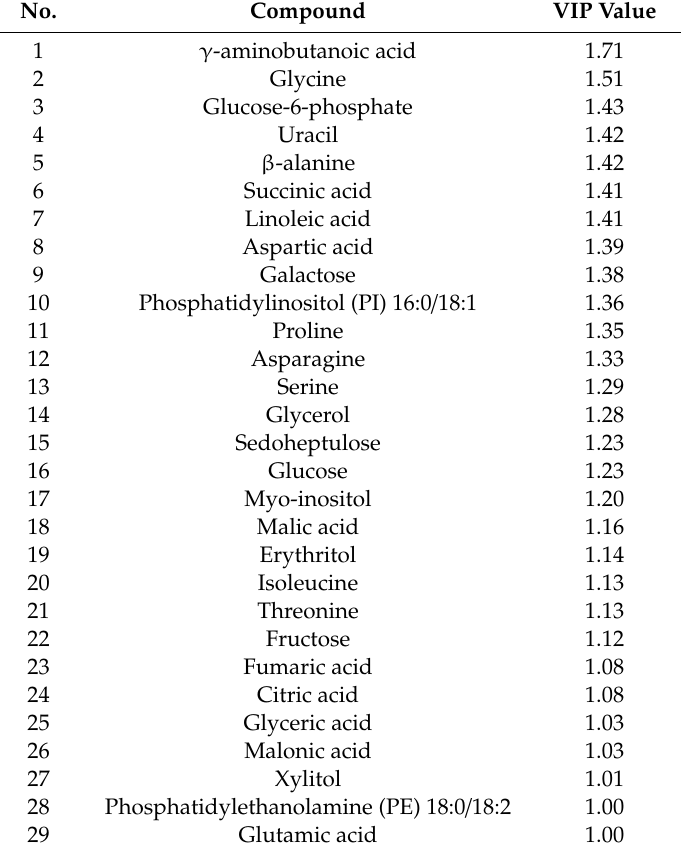
Table 5. Metabolites and lipids with VIP values > 1.0 in the PLS-DA